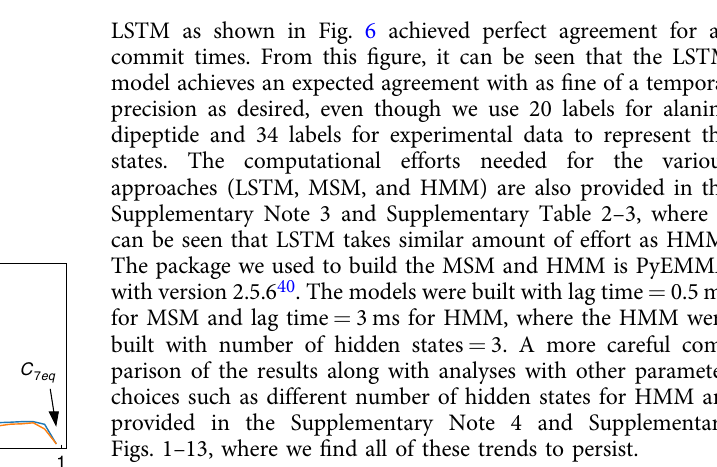
Table 1 Kinetics for alanine dipeptide.